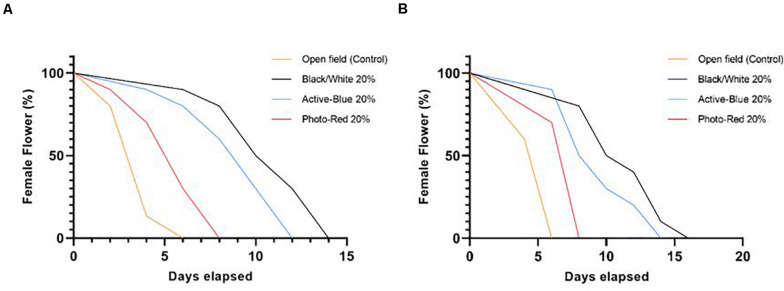
Stigmas receptivity among the different treatments. Data were collected during phenological recording. The days were counted starting from the phenological stage R8 (full bloom), until stage R9 (stigmas are wilted and dark red). (A) cv. Tonda di Giffoni; (B) cv. Barcelona. Log-rank (Mantel-Cox) test, P < 0.0001.